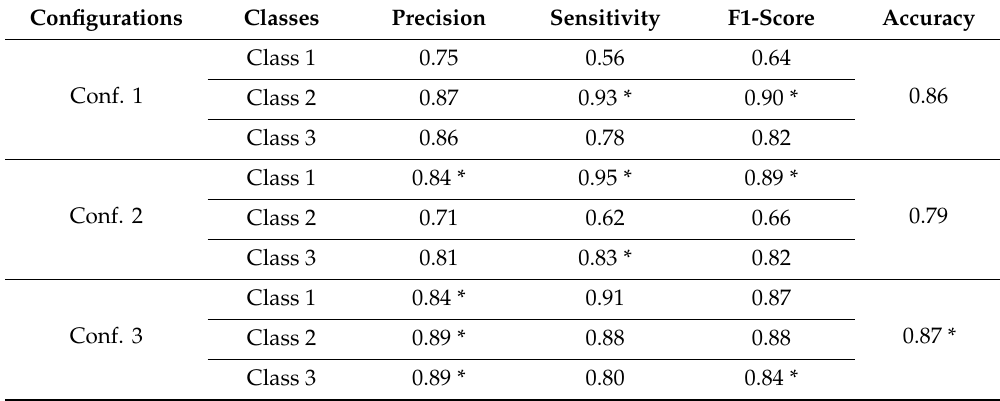
Table 8. The error performance (precision, sensitivity, F1-score, and accuracy) of the localized model KNN-LS-SVM model for the three di ff erent 3-class configurations based on leave-one-out (LOO) testing